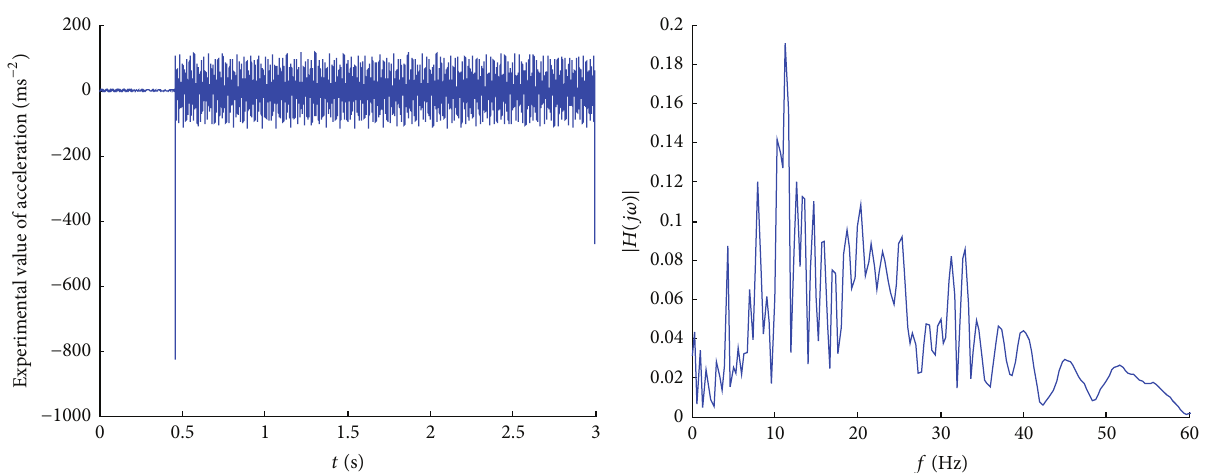
Figure 14: The acceleration value and the frequency response function 𝐻(𝑗𝜔) of the second experimental